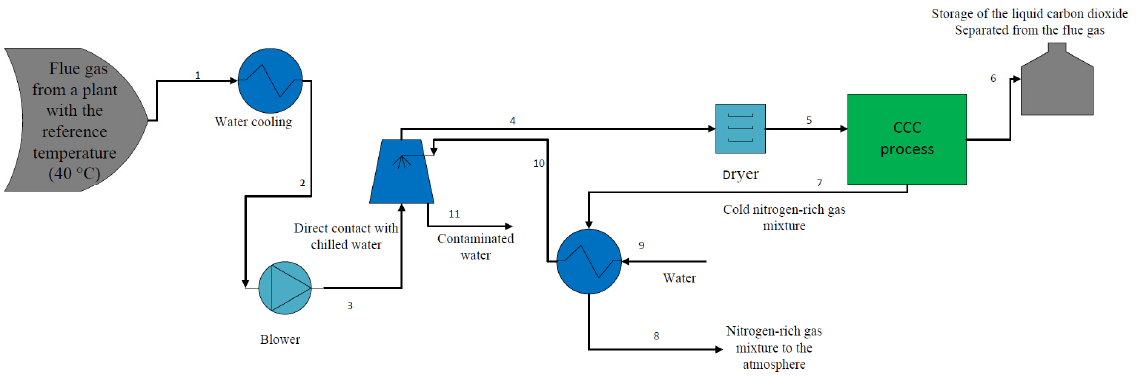
Figure 1. Flue gas pre-processing before entering CCC process.